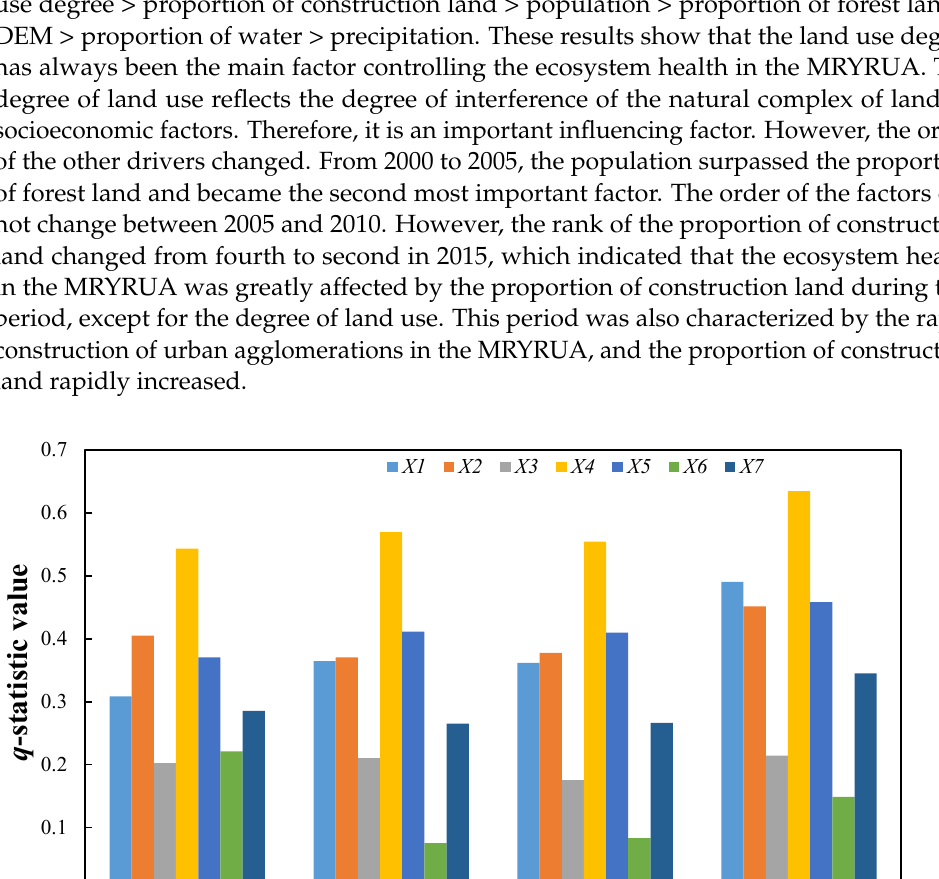
Table 3. Interaction detectors of the GeoDetector.